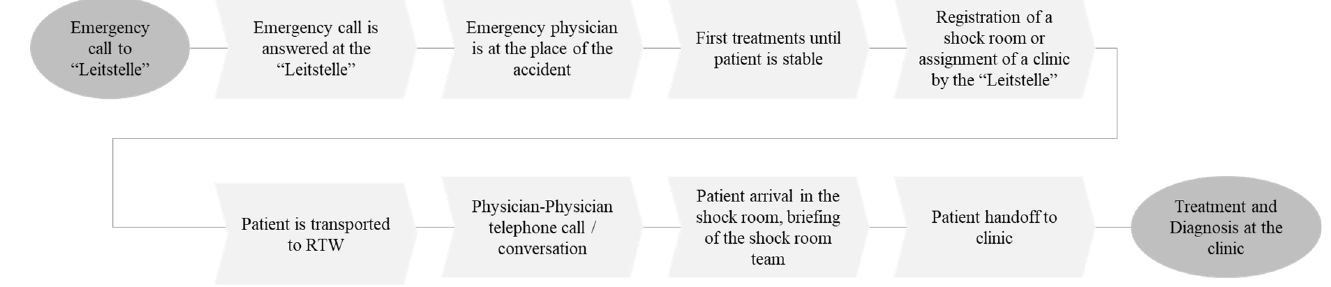
Figure 2. Standard emergency process.